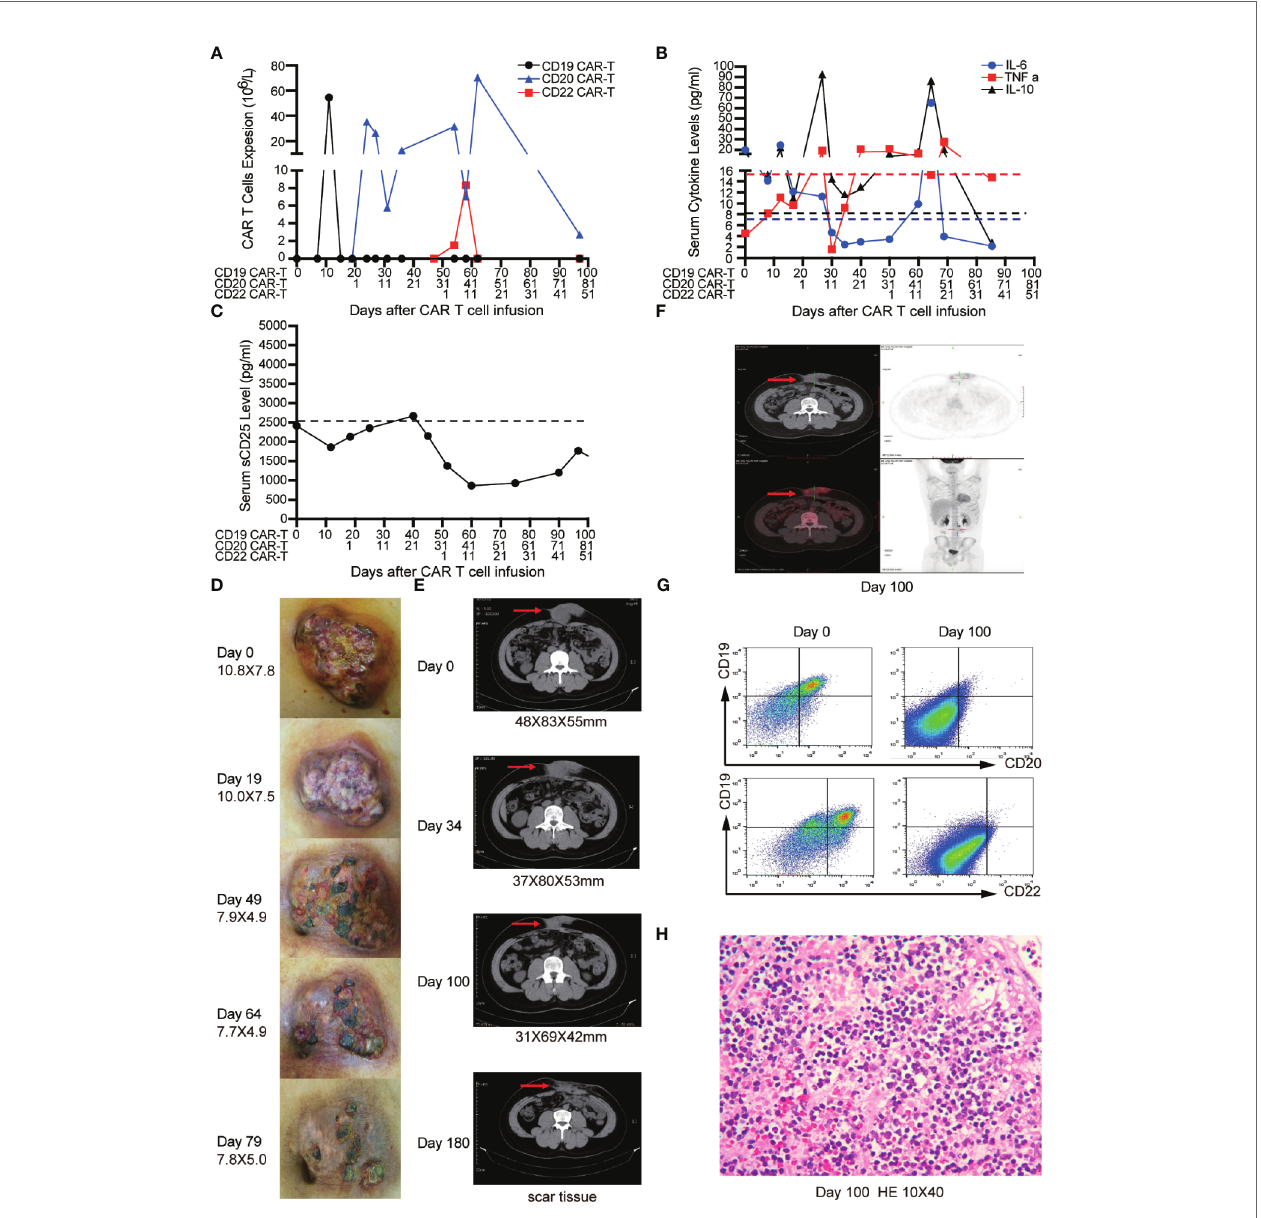
FIGURE 3 | Outcomes of short-interval sequential CAR-T cell treatment in case 1. (A) CAR-T cell expansions during CD19, CD22, and CD20 directed CAR-T cell therapies. Detection of cytokines (IL-6, TNF- a and IL-10) (B) and serum soluble CD25 levels (C) during sequential CAR-T cell therapies. The shrinkage of tumor mass (D) and computed tomography (CT) images (E) on the timelines of sequential CAR-T cell therapies. (F) Position-emission tomography (PET)/CT on day 100 after CAR-T cell therapies. (G) FCM analysis of CD19, CD20, CD22 expression on tissue which were obtained by fi ne needle aspiration biopsy before and after CAR- T therapies on day 100. (H) Immunohistochemistry (IHC) for excisional biopsy after